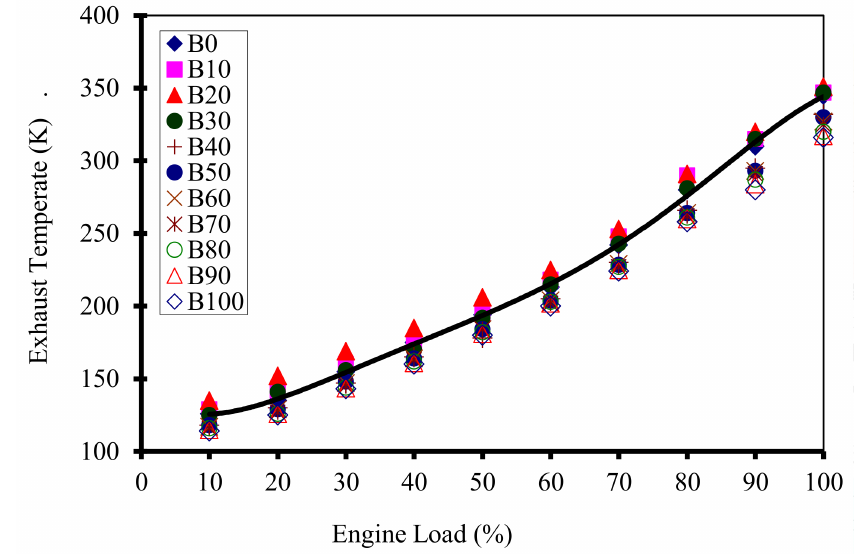
Figure 4. Temperatures of output exhaust